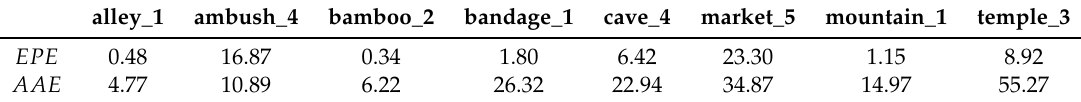
Table 5. Results obtained by the PSO in the MPI-Sintel selected training set.